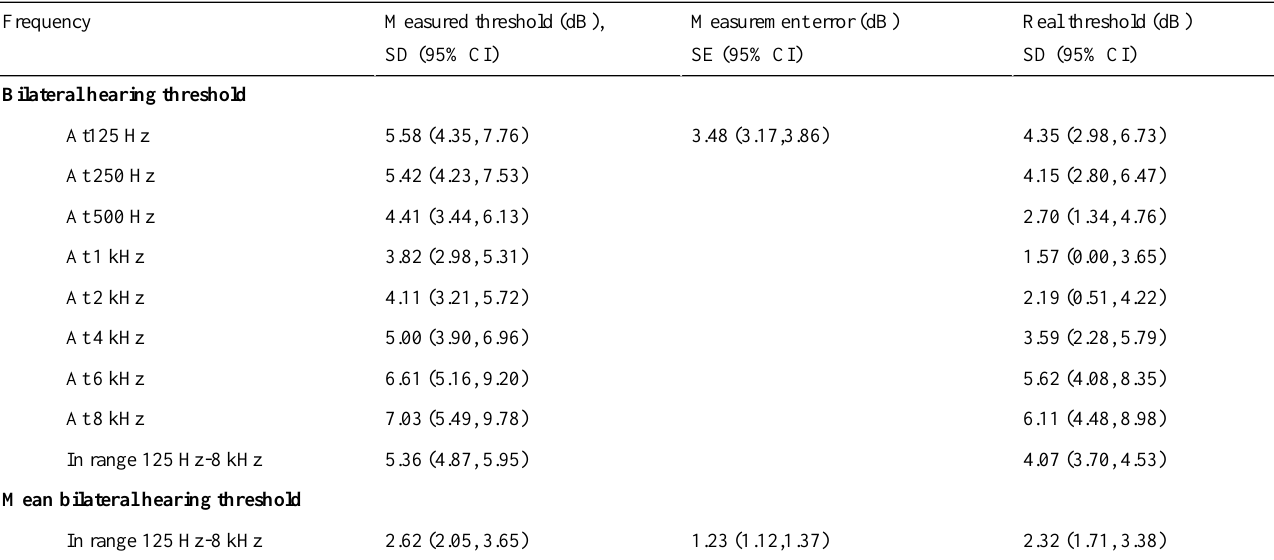
Table 3. Standard deviation of the bilateral hearing threshold measured in series 1 by 25 participants, estimated measurement error and standard deviation of the real bilateral hearing threshold after eliminating the measurement error with corresponding confidence intervals at P